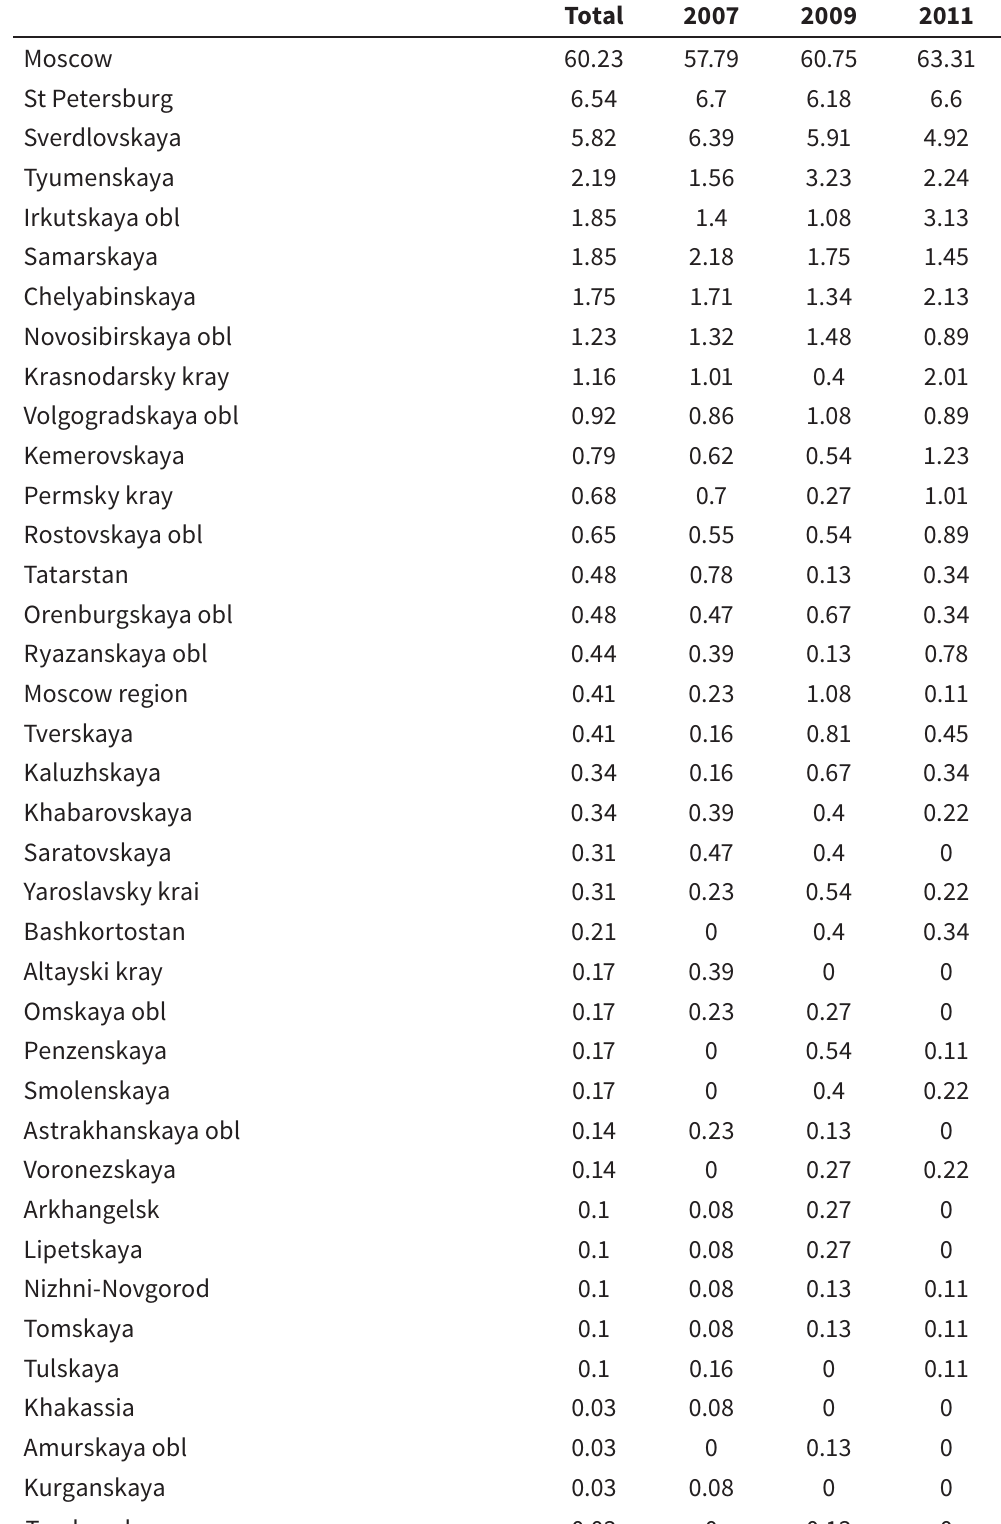
Table A1 Migrants’ distribution across Russian regions,